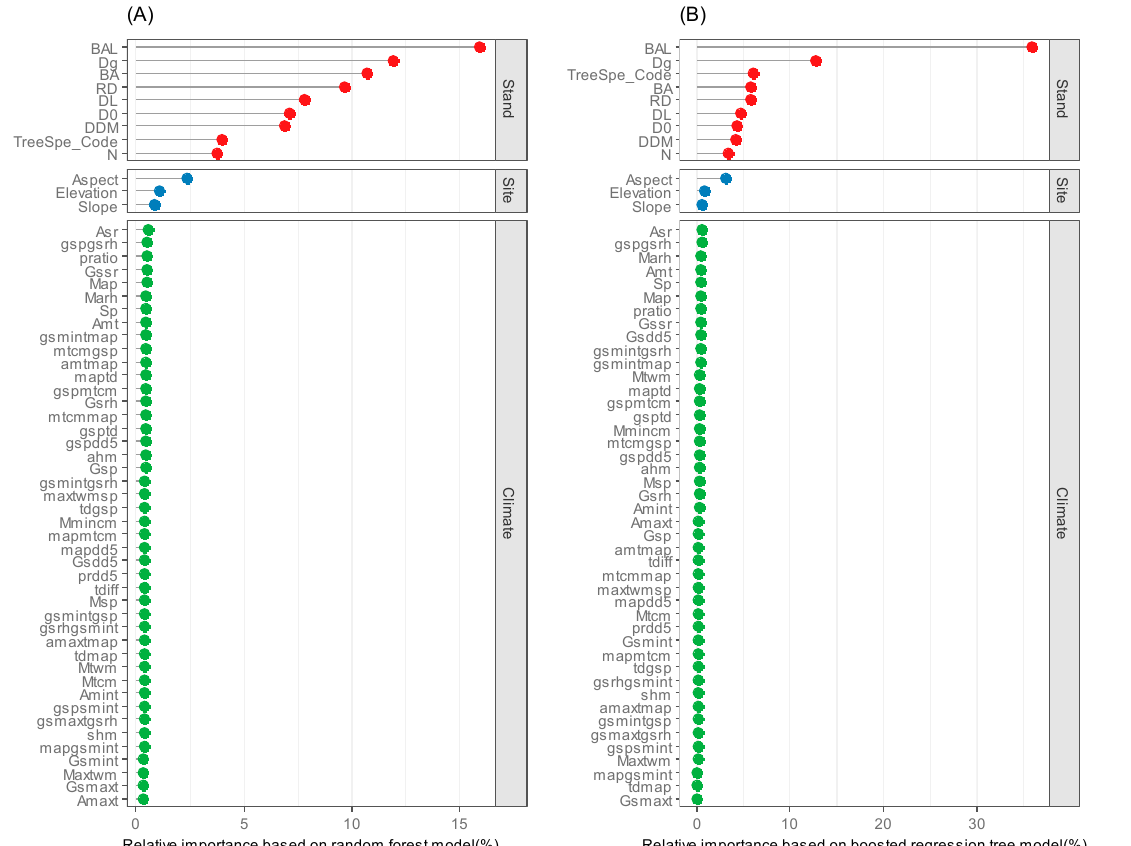
Figure 5. Relative importance of each variable as determined from ( A ) random forest (RF), and ( B ) boosted regression tree (BRT), which were normalized to 100%. The explanations of stand factors: BAL is the sum of basal area larger than the subject tree, Dg is average DBH, BA is the basal area per hectare, RD is the ratio of DBH of subject tree to average DBH, DL is the sum of square DBH in trees which are larger than subject tree, D0 is the individual tree DBH at the beginning of 5-year interval, DDM is the ratio of DBH of subject tree to the maximal DBH, TreeSpe_Code is the tree species, and N is the number of trees per hectare. The explanations of site factors: Aspect is aspect, Slope is slope and Altitude is altitude. The explanations of climate factors were presented in Table